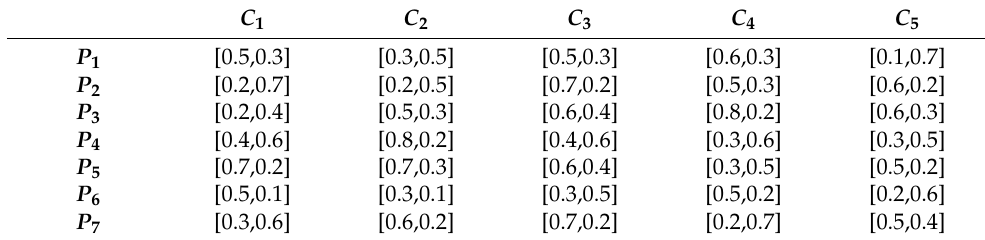
Table 2. Original evaluation criteria information matrix at the moment t 1 .